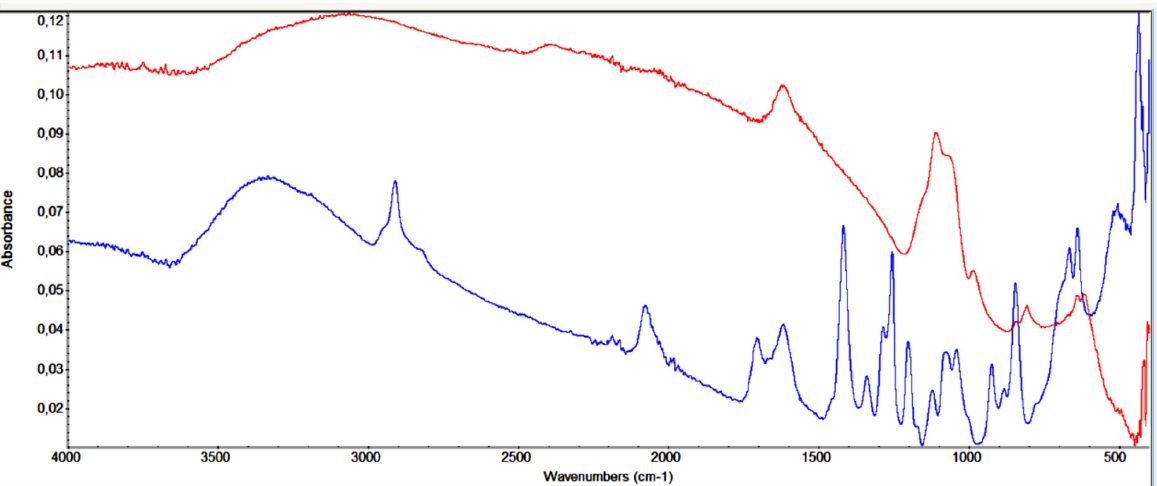
Figure 4. The FTIR spectra of w-ZnS washed solution (acetone and ethanol) for different time: 5 min (blue) and 30 min (red).